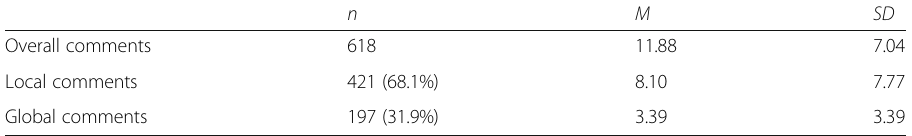
Table 2 Descriptive statistics of comments generated by the end of the study n